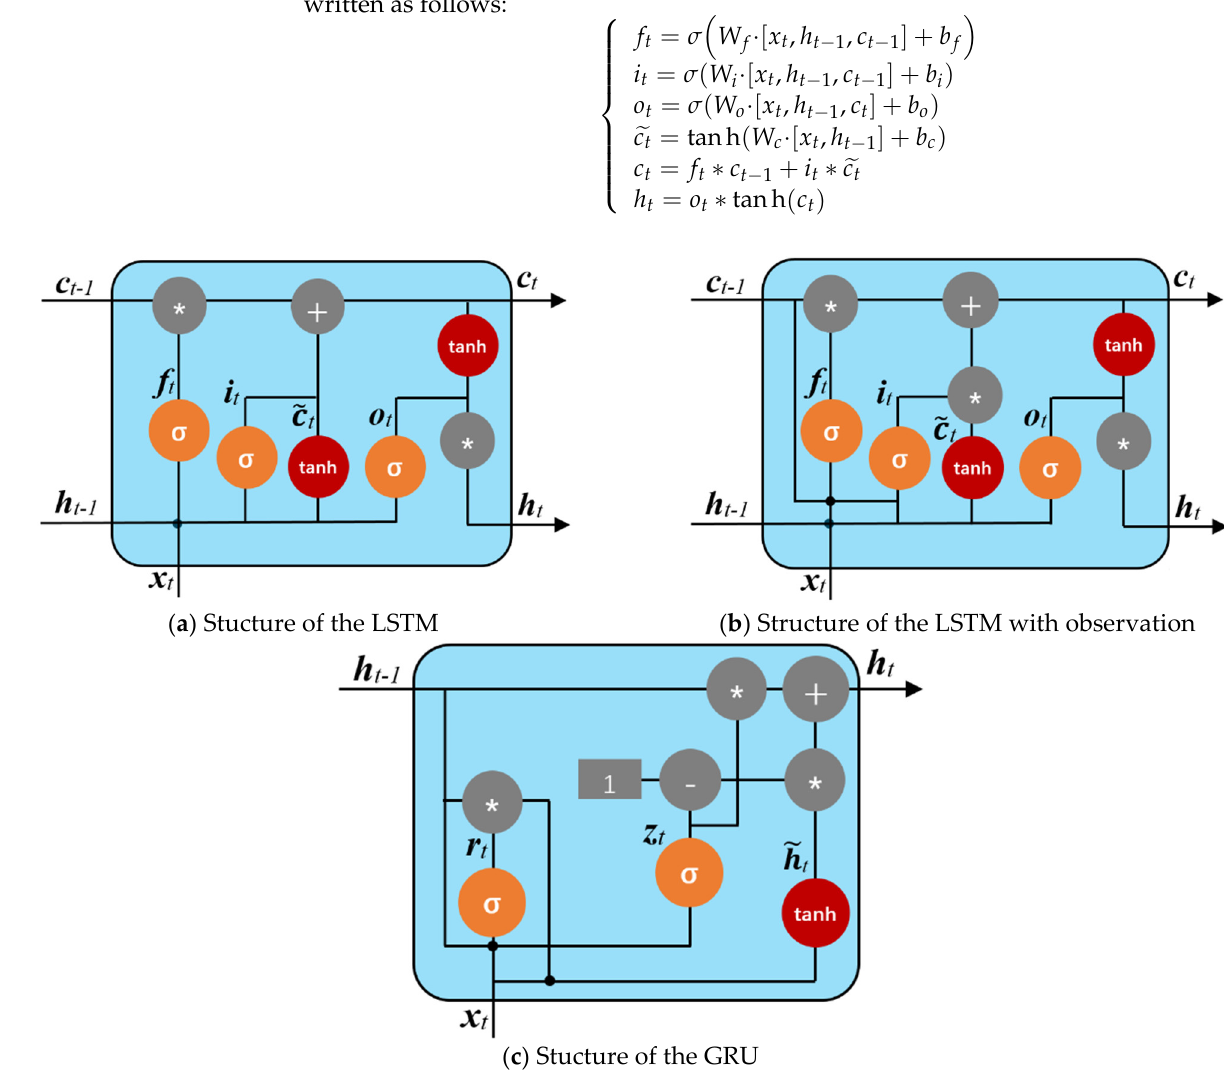
Figure 6. Three different inner structures of LSTM networks.